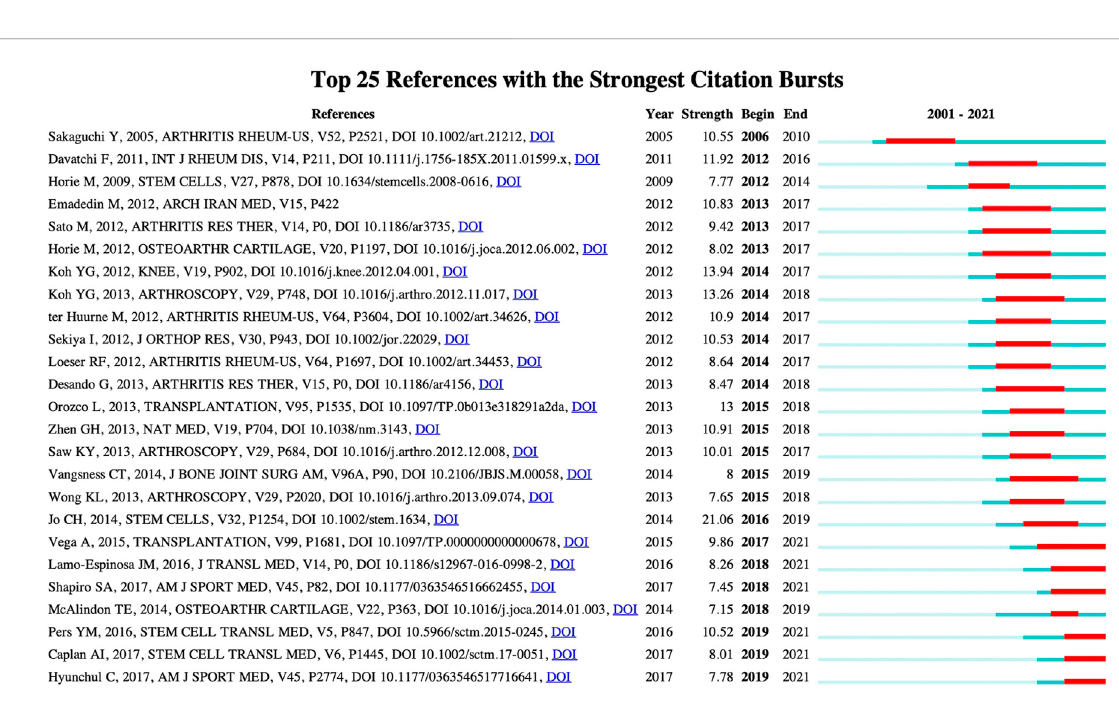
FIGURE 11 Top 25 cited references with the strongest burst value on stem cell therapy for KOA research. Dark blue bar indicates the years in which reference cited co-occurrence slightly increases. The red bar shows that reference cited rises